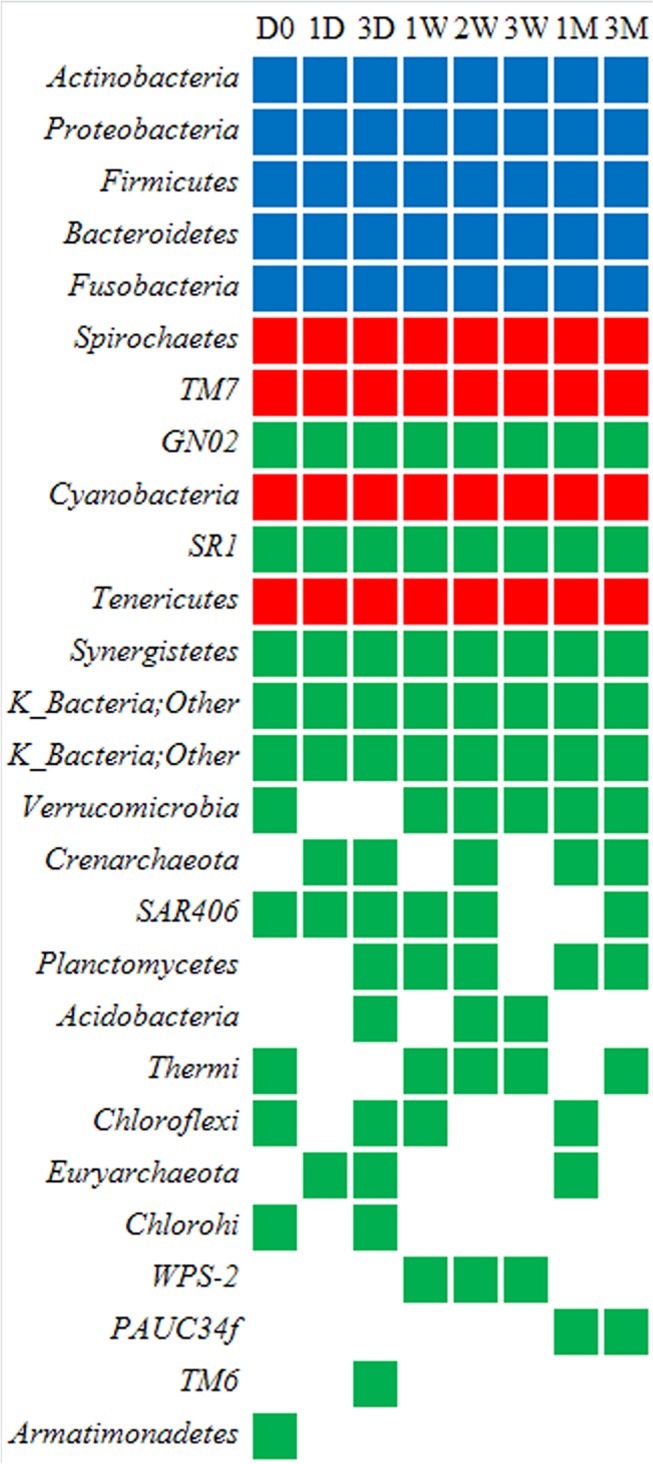
Existence of 27 phyla at each sampling time.Data given in the figure are a pool of eight subjects. 3M, 3months; 1M, 1 month; 3W, 3 weeks; 2W, 2 weeks; 1W, 1 week; 3D, 3 days; 1D, 1 day; D0, day 0. Corresponding color block would be obtained if a phylum was detected at each time slot. The five dynamic phyla core illustrated by the blue blocks are common in all the subjects across the different intervals. The red blocks are the phyla common in all subjects but not across all the time periods. The four phyla (indicated by red blocks) and the five phyla (indicated by blue blocks) that common in all the eight subjects constitute the core phyla. The other 18 phyla that are failed to be found in all subjects are marked by green blocks. They are transient phyla.